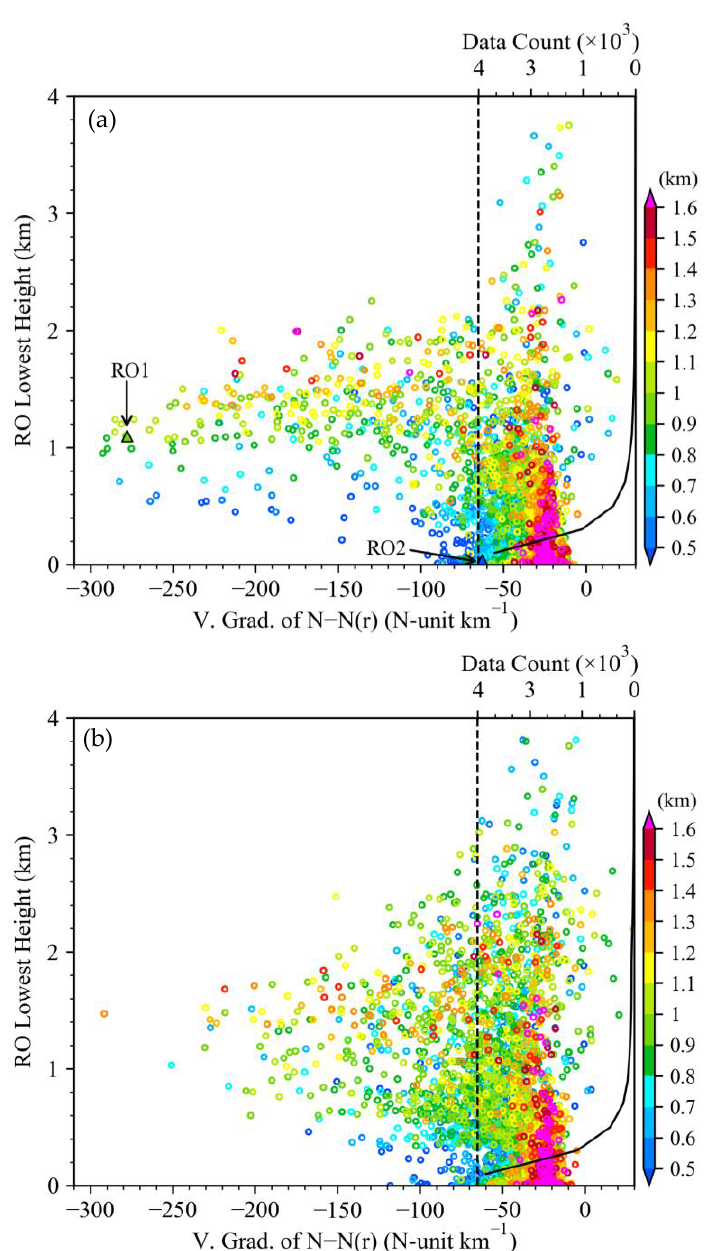
Figure 7. Scatter plots of the lowest heights versus the vertical gradient of N − N ( r ) for all COSMIC2 RO profiles in August 2020 over ( a ) the SEP and ( b ) SCP areas. The PBL height for each RO profile is indicated in colors, and the number of the lowest RO data with the vertical gradient of N − N ( r ) being greater than − 65 N-unit km − 1 (black dashed line) at 0.2-km interval is shown by black curve. We notice that there are still quite a few RO profiles on the right side of the dashed line whose lowest altitudes are high, suggesting that some RO profiles are unable to penetrate down into the lower troposphere even though the vertical gradient is weak. The impacts